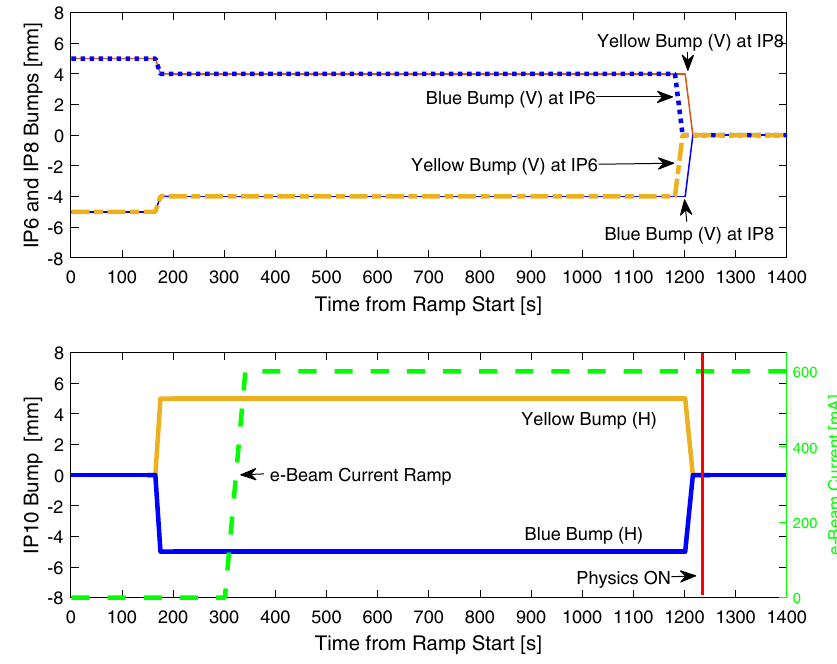
FIG. 18. Separation bumps and electron beam